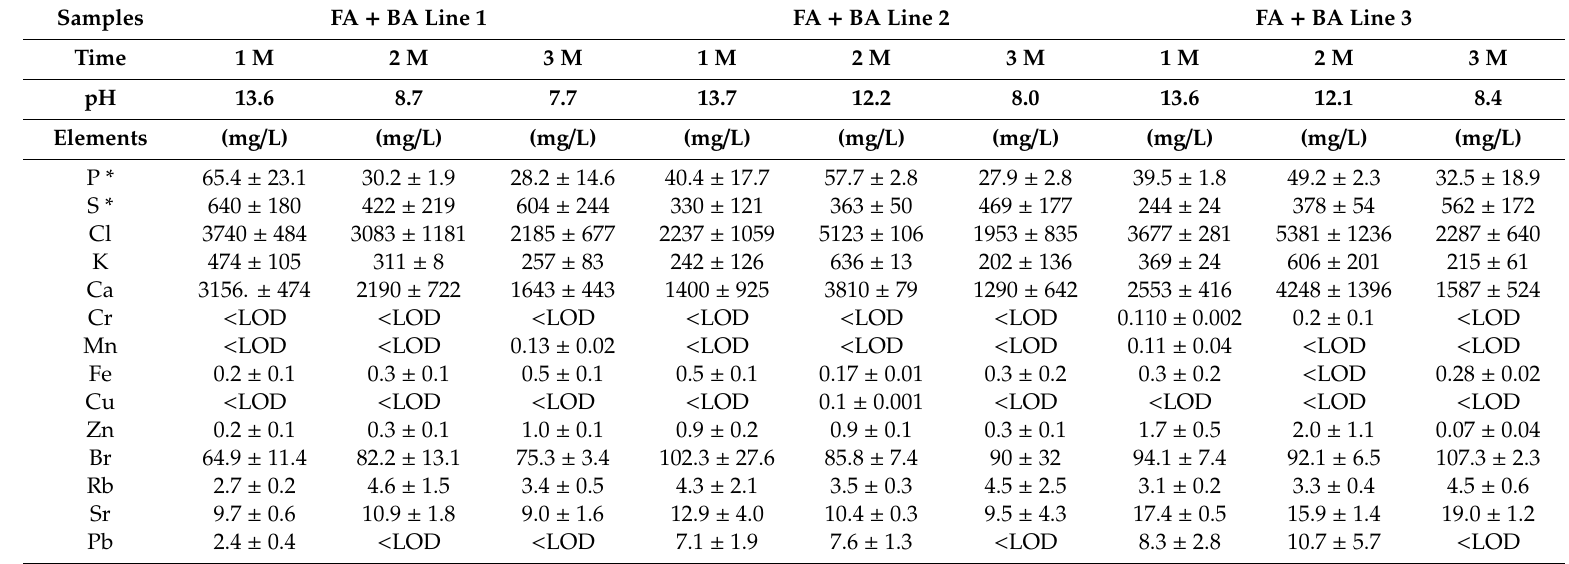
Table 4. Results of the TXRF analysis and pH values of samples stabilized following the b) procedure with Sewage-MSWI FA from di ff erent lines after (1), (2) and (3)